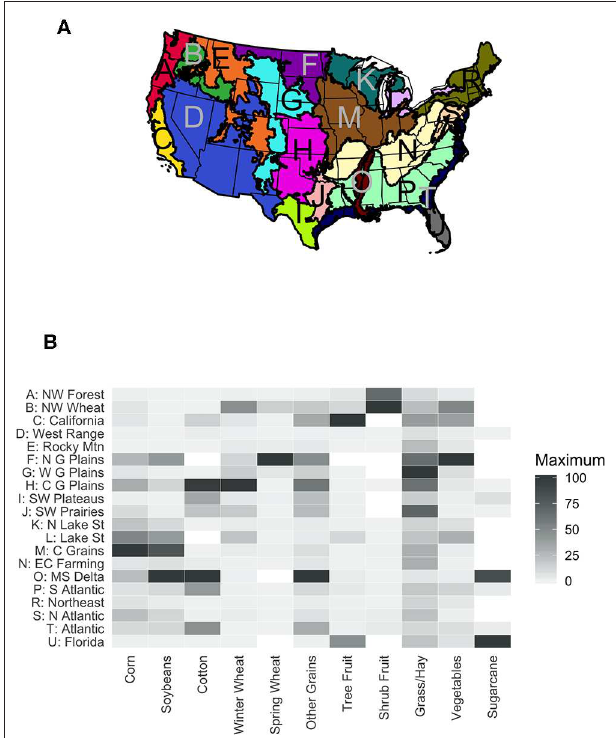
FIGURE 1 | The boundaries of each of the twenty USDA Land Resource Regions (A) and the dominant crop area in each from the 2018 Cropland Data Layer (B) . The full names of each region are given in Table 1